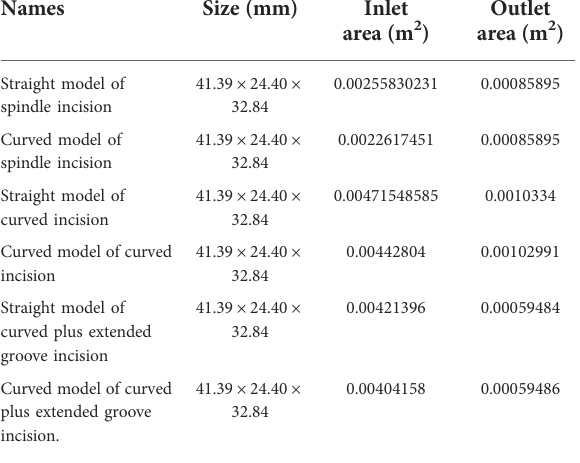
TABLE 6 Size and inlet/outlet area of models.